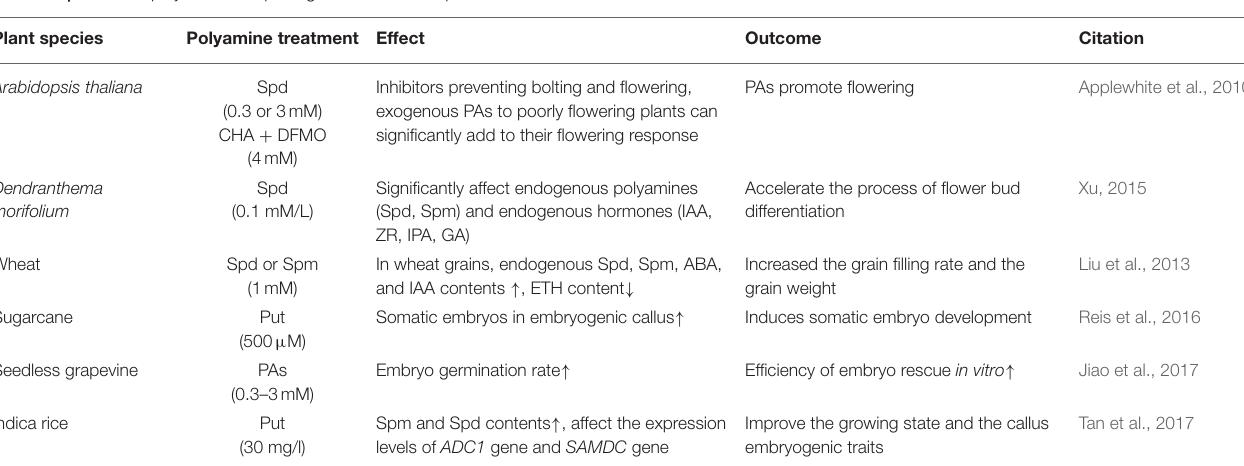
TABLE 3 | Effects of polyamines on plant growth and